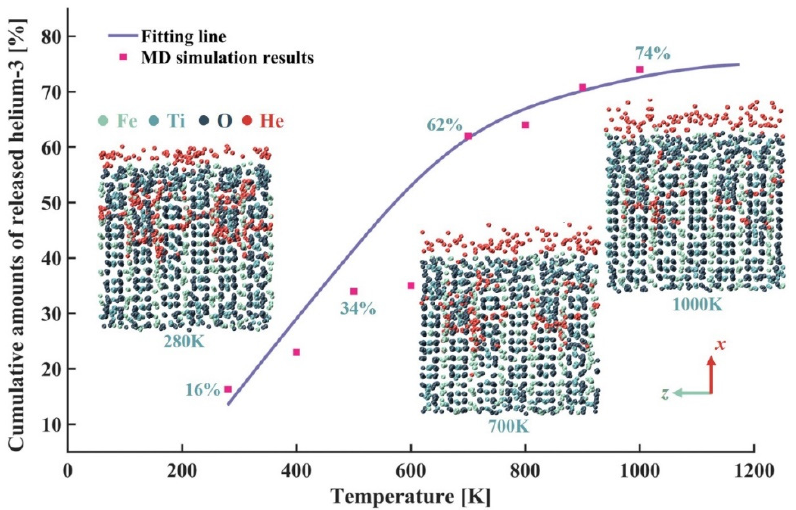
Figure 5. Variations in cumulative amounts of released helium-3 with temperature. The insets show the diffusion and thermal release of helium-3 in ilmenite at 280 K, 700 K, and 1000 K, respec- tively.